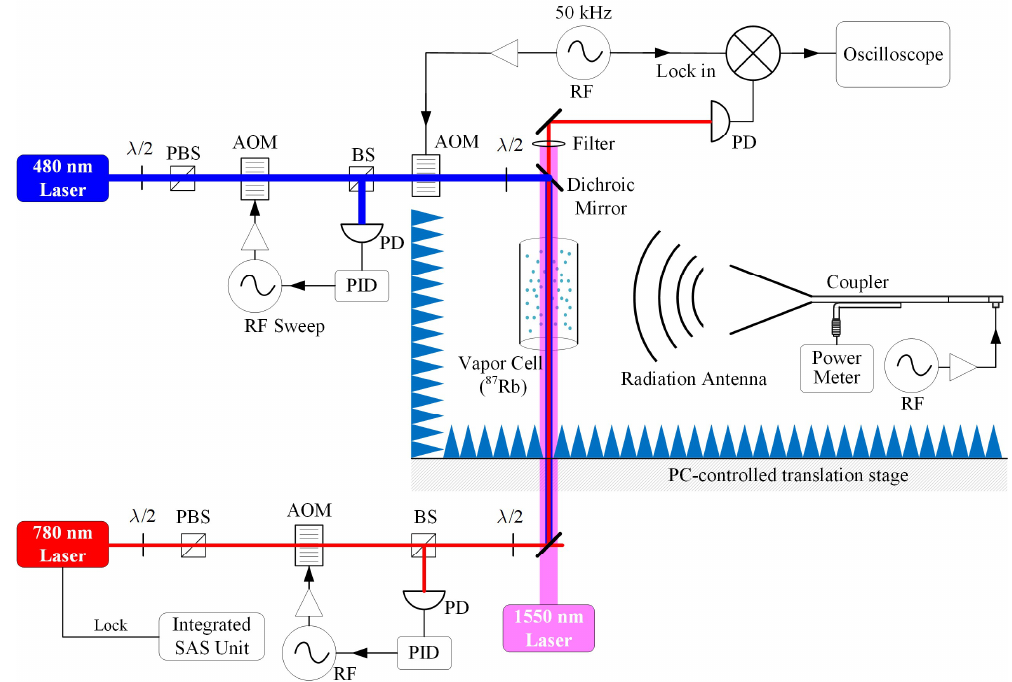
Figure 3. Schematic of experimental setup: AOM, acousto-optic modulator; BS, beam splitter; PBS, polarizing beam splitter; PD, photo-diode detector; PID, proportional–integral–derivative controller; SAS, saturated absorption spectrum; λ /2, half wave plate.